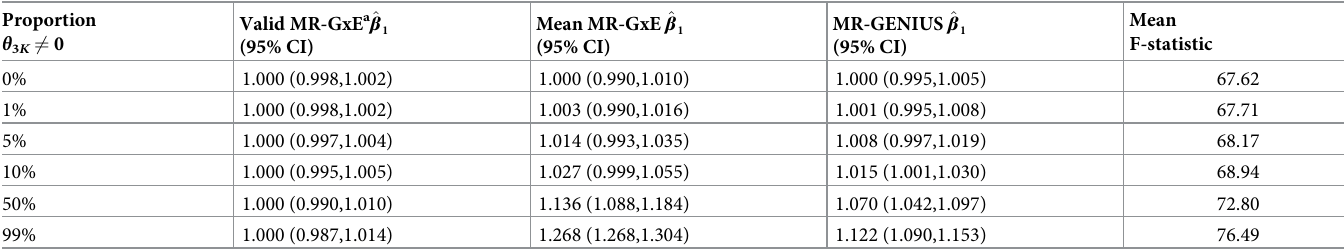
Table 2. Simulated results using differing proportions of non-zero gene-by-covariate interaction with respect to confounders (simulation 4). Proportion θ 3 K 6¼